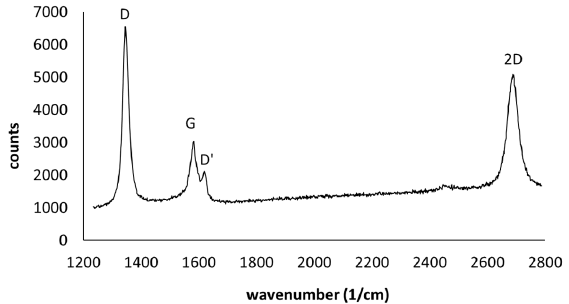
Figure 2. Example of the Raman spectrum of graphene after He + ions implantation with ion fluence 1015 cm − 2 .